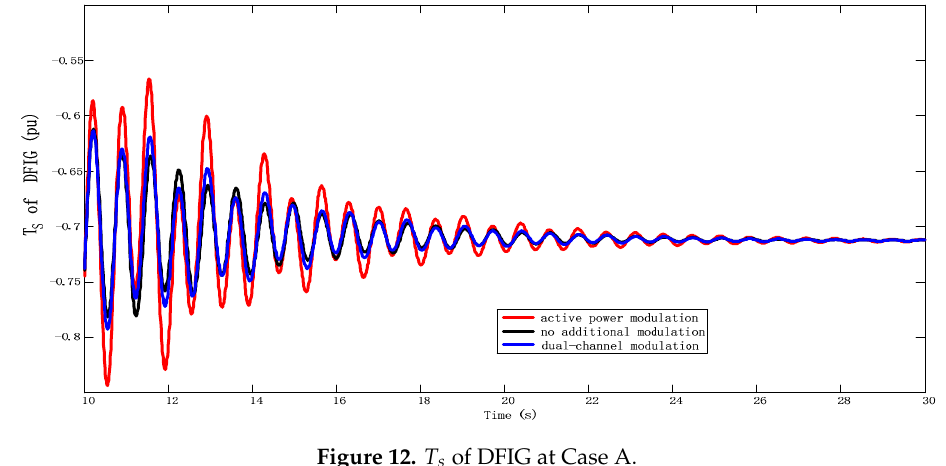
Figure 12. T s of DFIG at Case Figure 12. 𝑇 (cid:3046) of DFIG at Case A. Figure 12. 𝑇 (cid:3046) of DFIG at Case A.